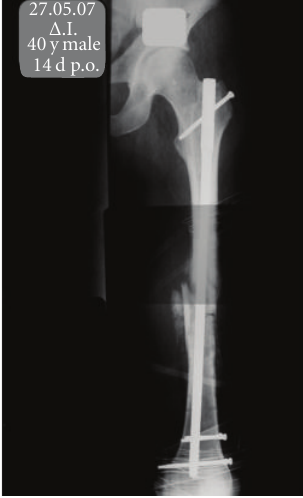
Figure 2: Revision of initial internal fixation with static intramed- ullary nailing and bone allografts.